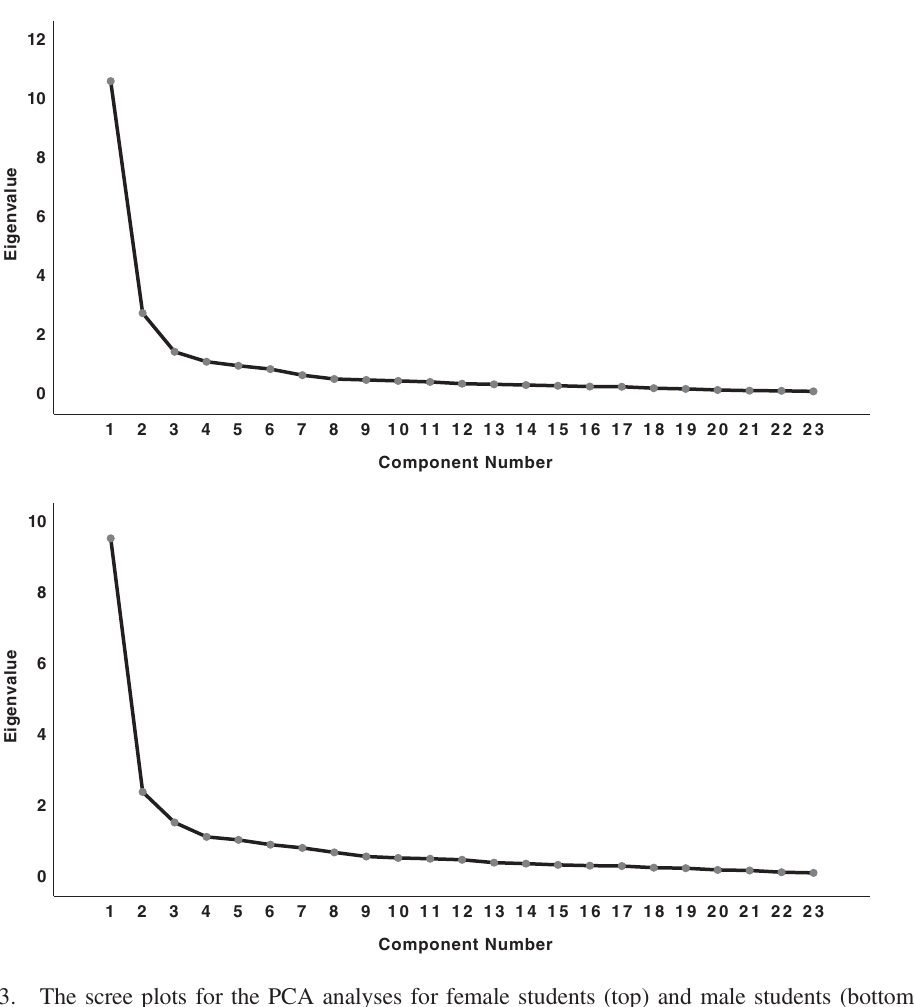
FIG. 3. The scree plots for the PCA analyses for female students (top) and male students